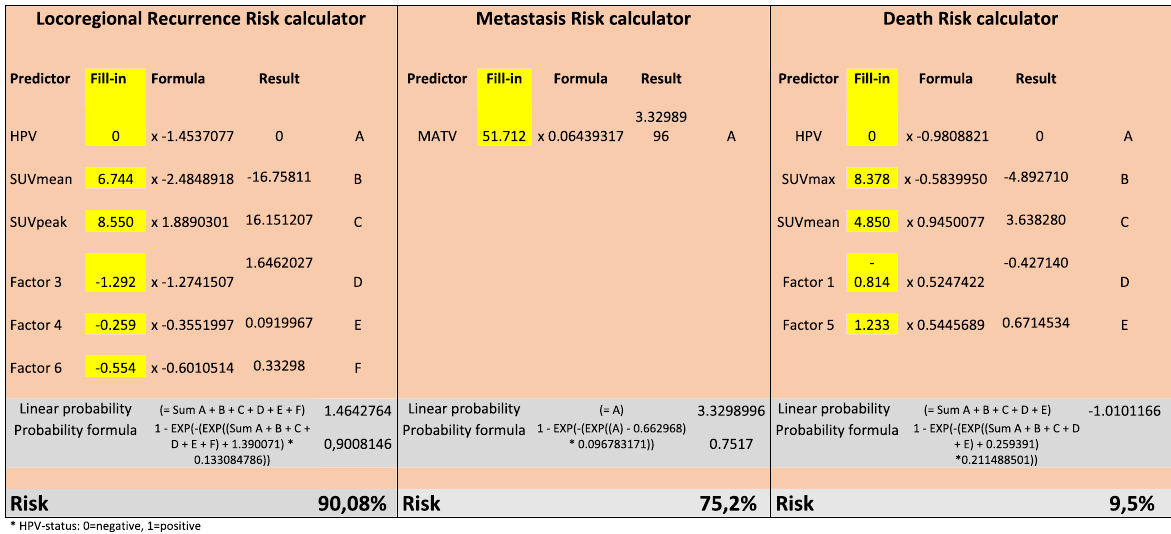
*HPV status: 0 = negative, 1 =